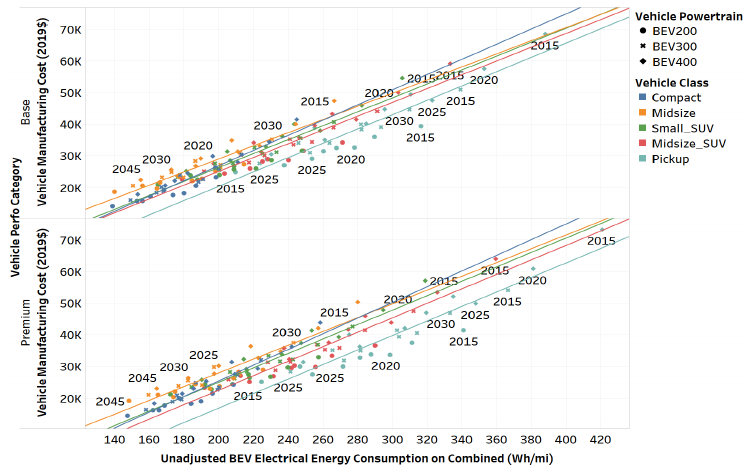
Figure 17. Manufacturing cost versus electrical energy consumption of